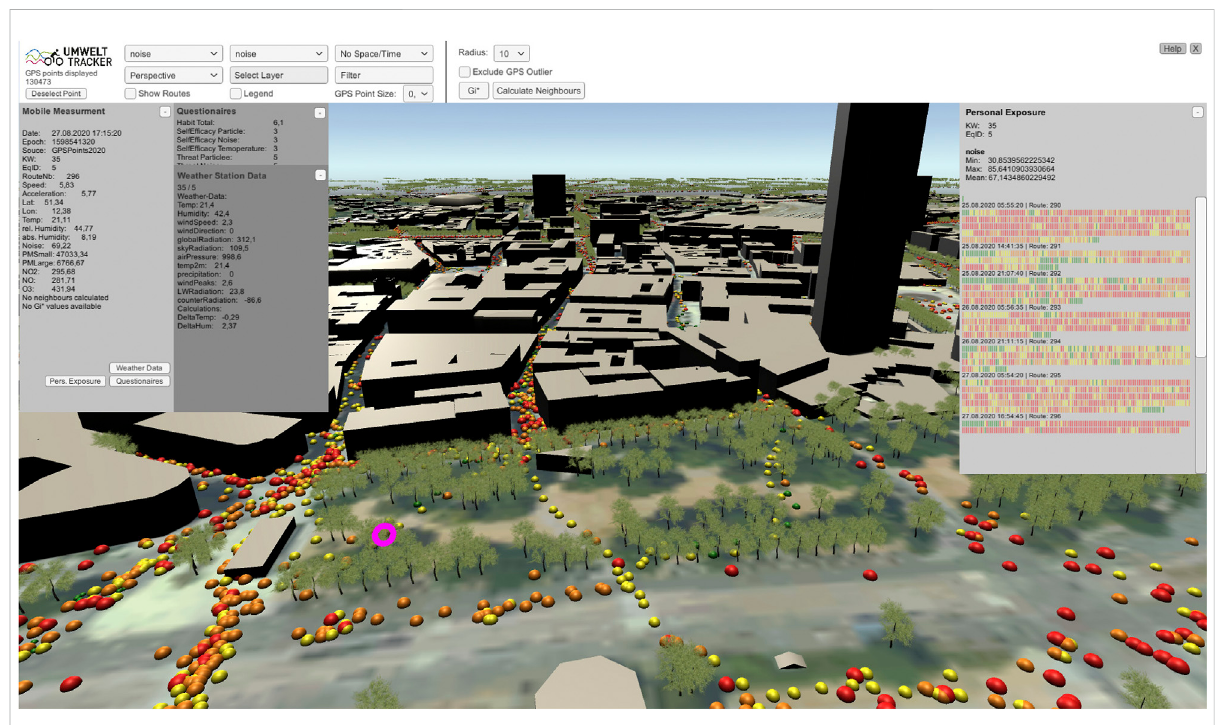
FIGURE 4 Screenshot of the application showing GUI and scene with data (mobile sensing data, buildings, vegetation, and satellite